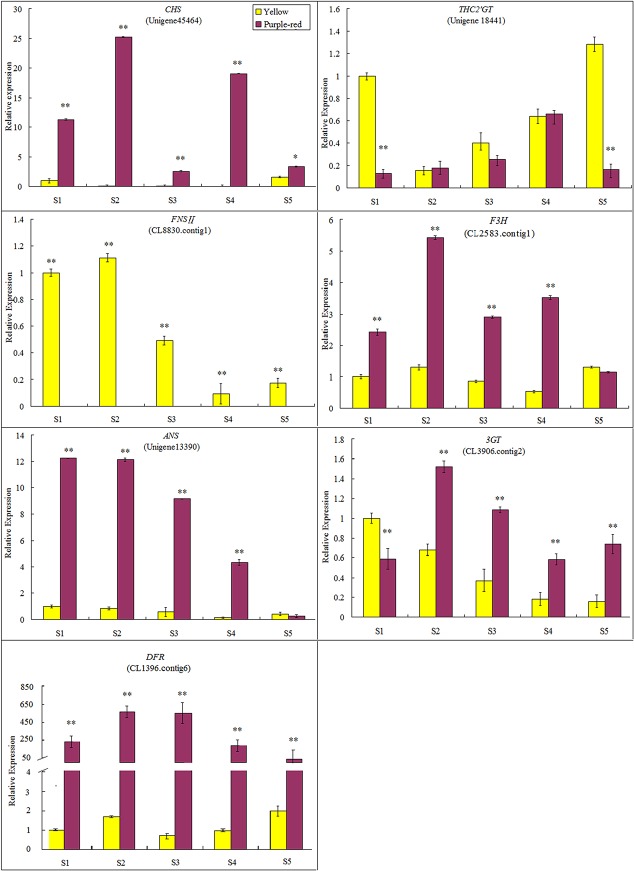
qRT-PCR analysis of seven flavonoid biosynthetic pathway-related candidate unigenes in Pl and Pd.qRT-PCR analysis was performed using total RNA from petals at each floral developmental stage (S1–S5). The expression in yellow petals at stage 1 was used as a calibration standard. Data from real-time PCR were normalized to the helicase gene expression value, and relative transcript levels are presented as means with standard errors (S.E.) of five replications.